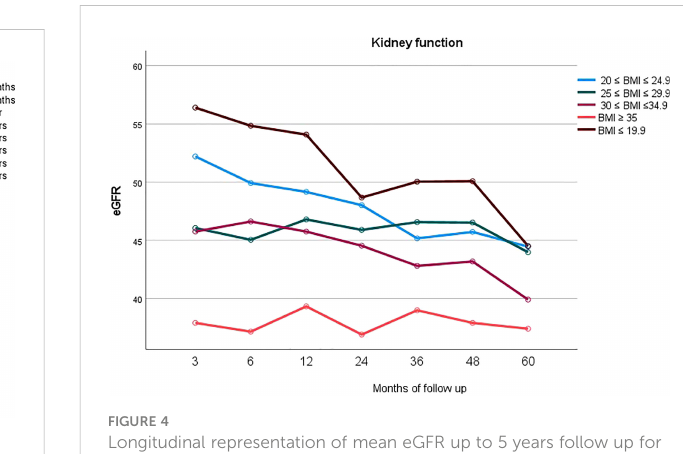
FIGURE 4 Longitudinal representation of mean eGFR up to 5 years follow up for the different BMI